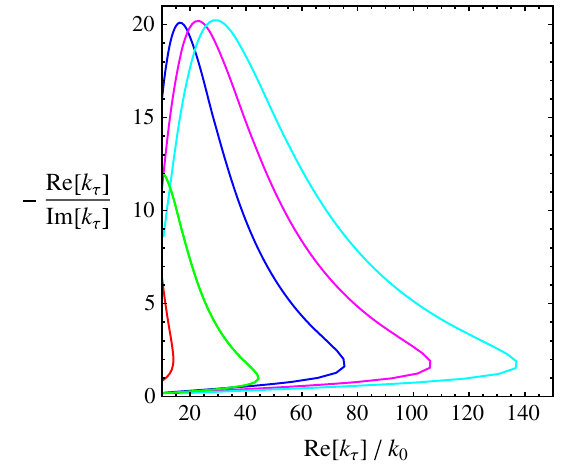
FIG. 12. The figure of merit, FOM ¼ − Re ½ k τ (cid:2) = Im ½ k τ (cid:2) , as a function of the real part of the in-plane momentum k τ for the silicon-sapphire hypercrystal and air interface. Note that as the ≡ ∂ ω = ∂ k 0 (see Fig. 10), group velocity for these modes v τ < g the surface waves in this system are left-handed (with the energy flow along the surface opposite to the in-plane momentum) so that Im ½ k τ (cid:2) < 0 , thus the negative sign in the figure of merit. FOM ¼ j Re ½ k τ (cid:2) = Im ½ k τ (cid:2)j , which describes the propagation